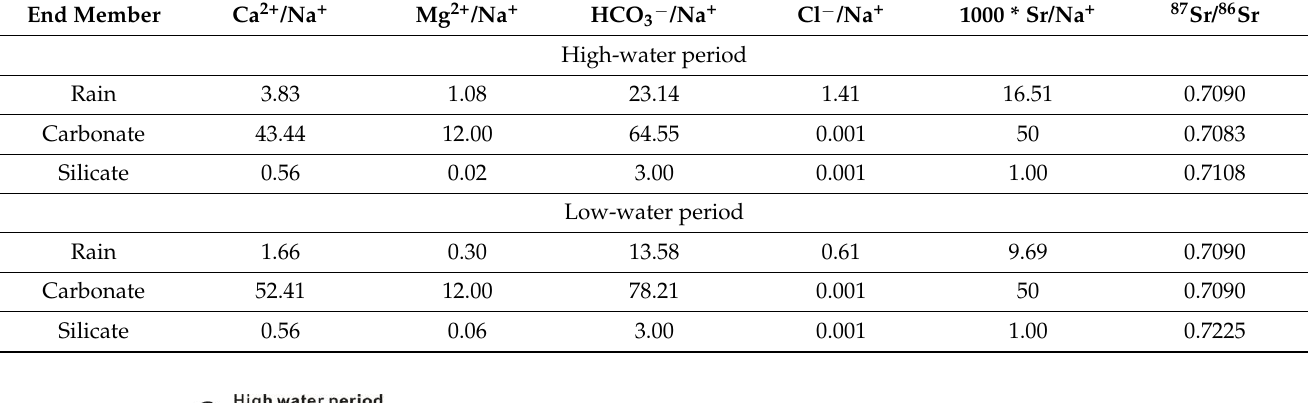
Table 4. End-member parameters of the model.